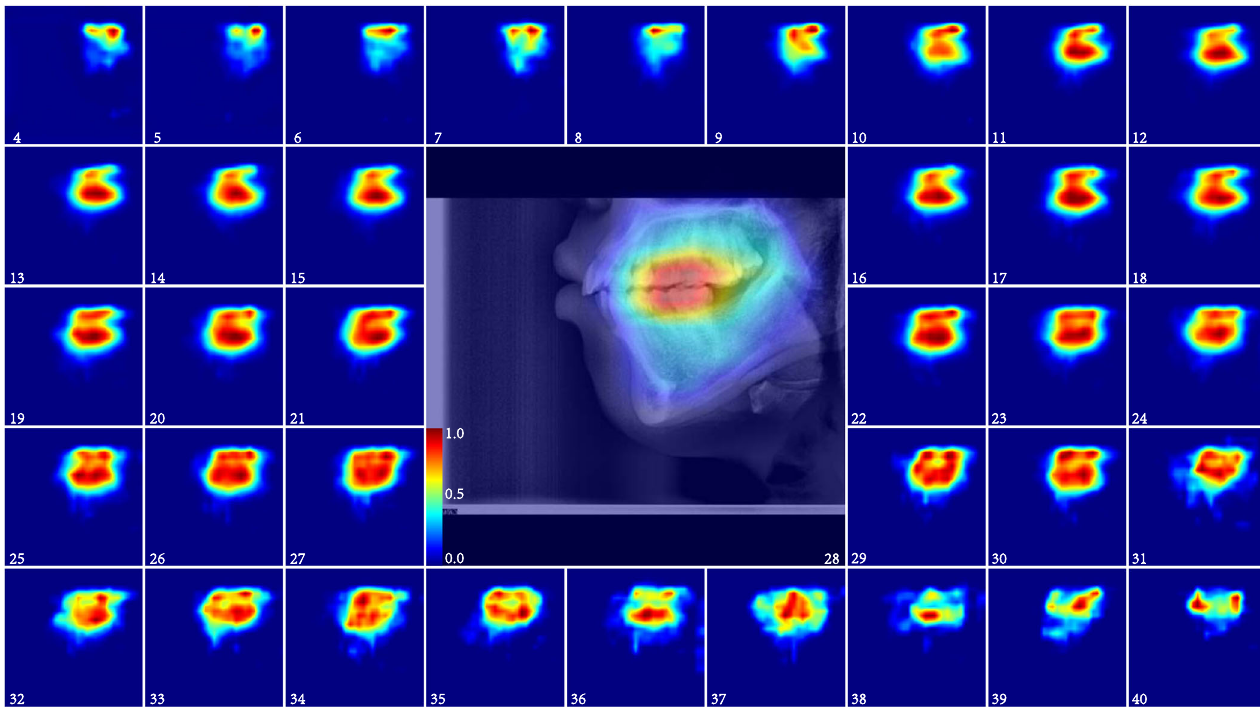
Fig. 3 The ARDA map of the teeth region from the ages of 4 to 40 years. The central panel displays the teeth region of a randomly selected 28-year-old subject overlaid with its corresponding ageing salience map to show the relative position between the ARDA map and the teeth region of the LCR image. Source data are provided as a Source Data fi le.